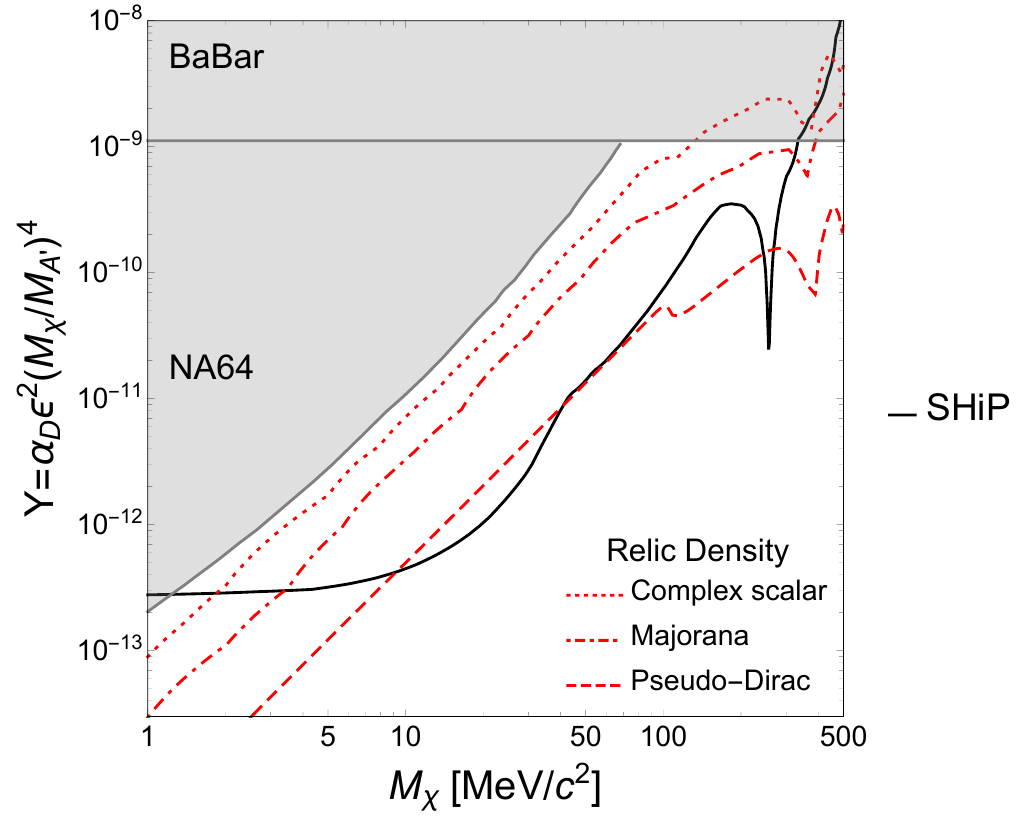
Figure 12. SHiP SND exclusion limit at 90% CL relative to a A 0 decaying into χ ¯ χ pairs for the benchmark point α = 0 . 1 and m = 3 m . The current strongest experimental limits are also D A 0 χ shown (BaBar [13], NA64 [27]), together with the three thermal relic lines corresponding to the scalar and the Majorana [3], and the Pseudo-Dirac DM [79]